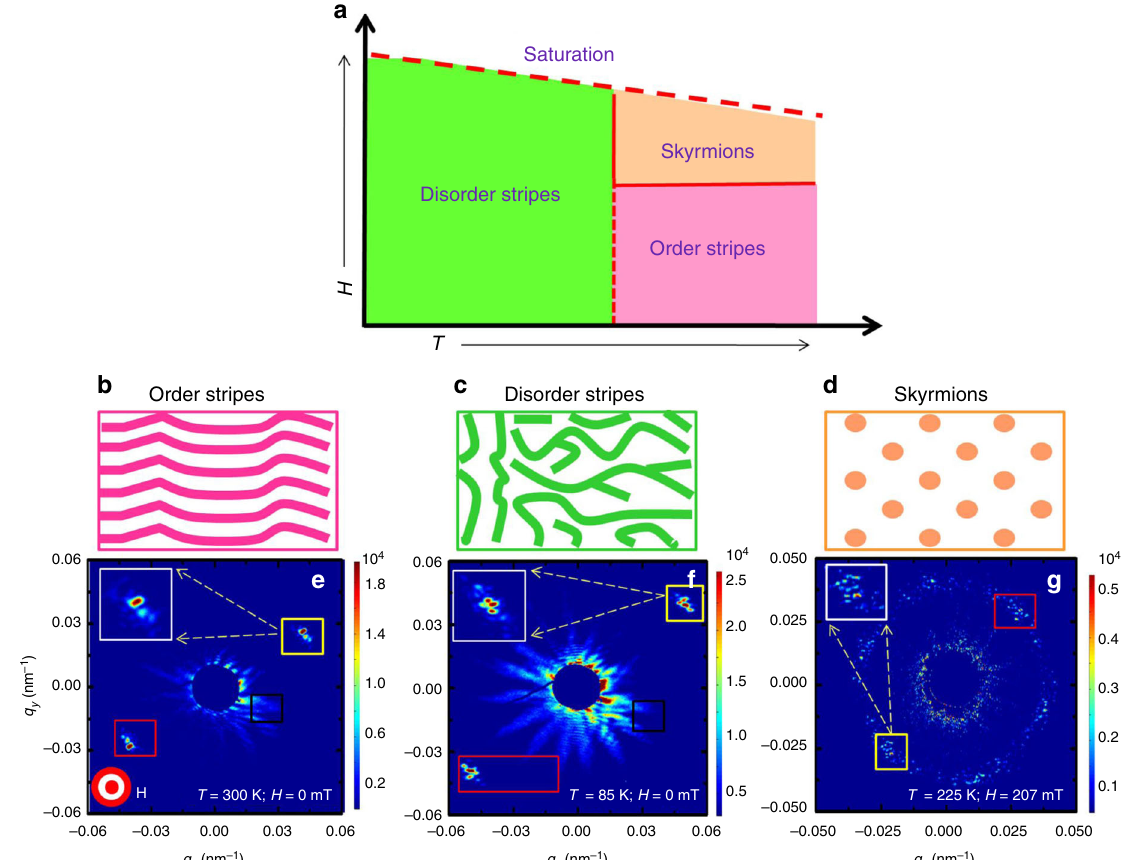
Fig. 1 Magnetic diffraction from stripes and skyrmions. a Schematic of phase diagram of the Fe/Gd sample as a function of temperature and applied magnetic fi eld. b – d Schematic of order stripes, disorder stripes, and skyrmion phase. e – g Magnetic diffraction spots in the three phases. The insets show enlarged image of the magnetic diffraction spots that are enclosed in yellow box. The red and black boxes are the regions of interest of magnetic diffraction and airy fringes, respectively, for calculating the pair-wise correlation coef fi cients. The box sizes are the same for each data set, except for the disorder stripe diffraction spot where it is elongated to account for the peak